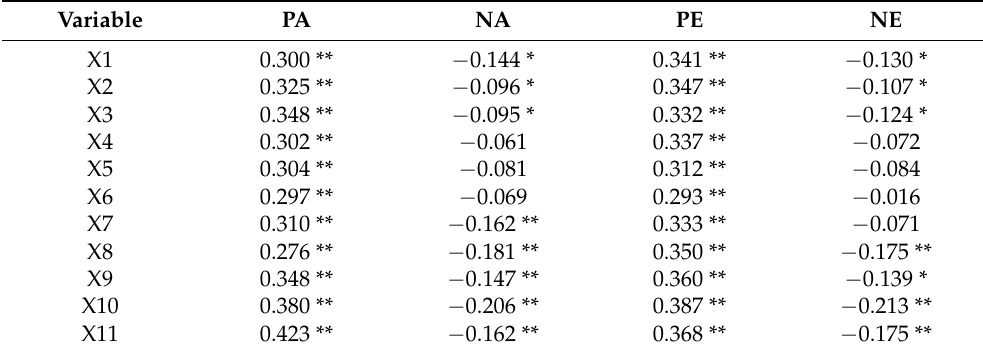
Table 3. Simple correlation analysis between subjective wellbeing dimensions scores and scores of perceived neighbourhood environment